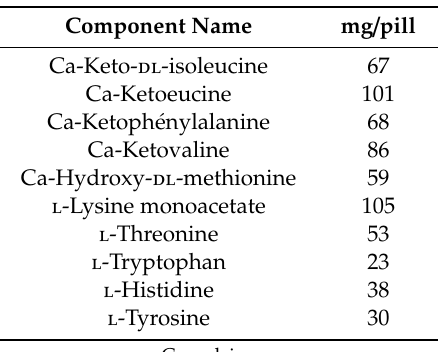
Table 1. Ketoacid analogues